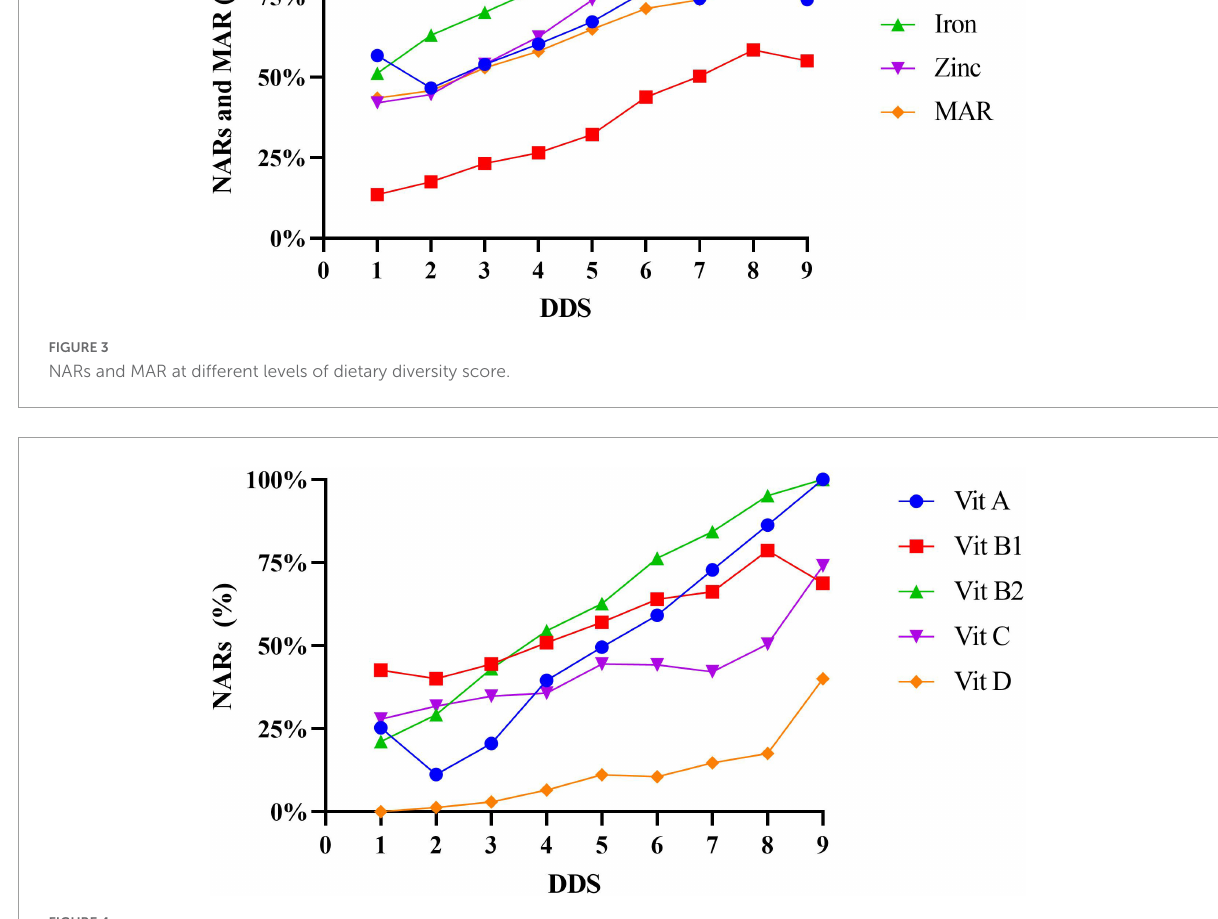
FIGURE4 NARs of selected vitamins at different levels of dietary diversity